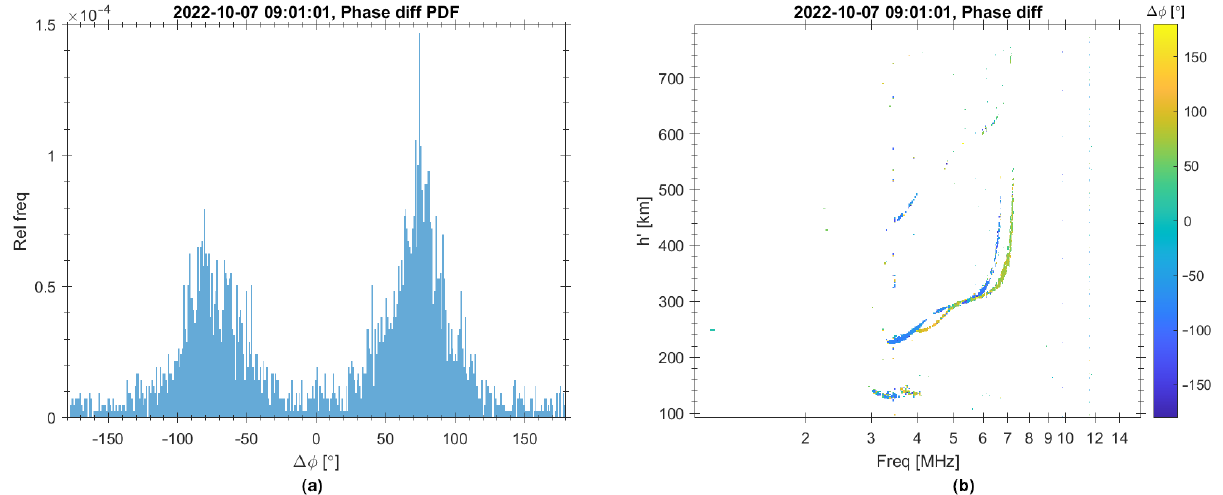
Figure 2. ( a ) Phase difference distribution and ( b ) ionogram (phase difference color coded) obtained using ISDR at the “Akademik Vernadsky” station on 7 October 2022. Additional information can be found in Supplementary Materials.